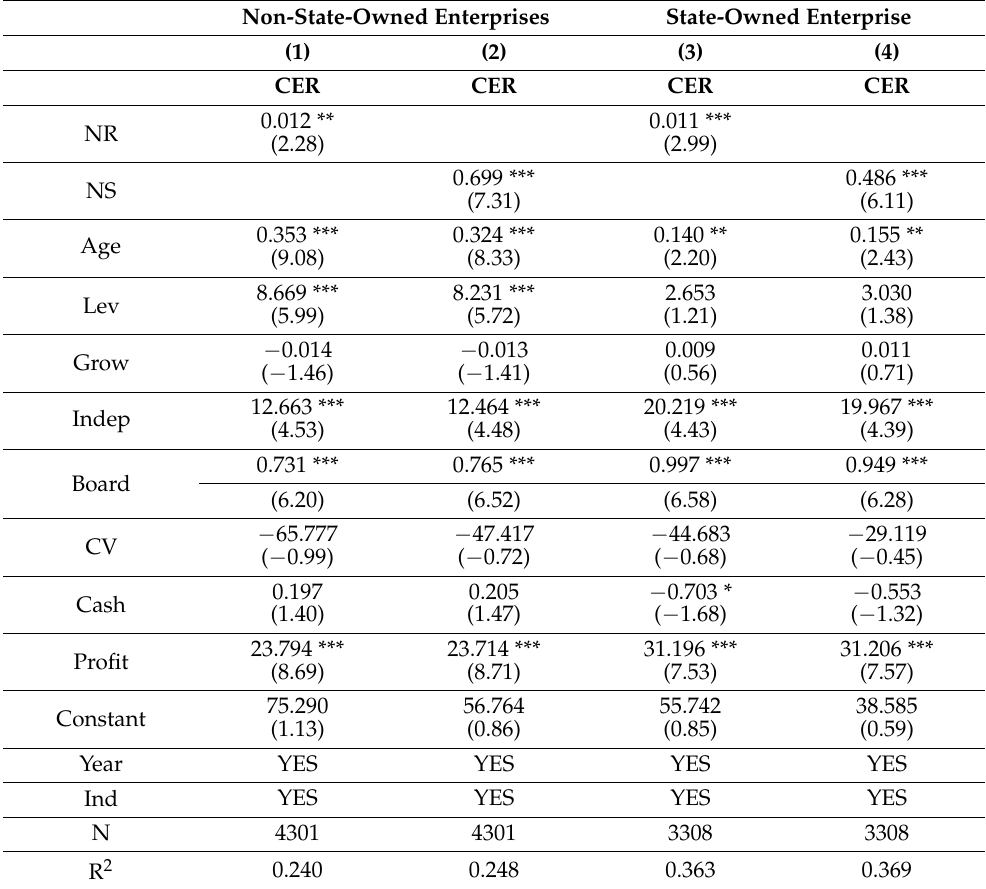
Table 12. The impact of